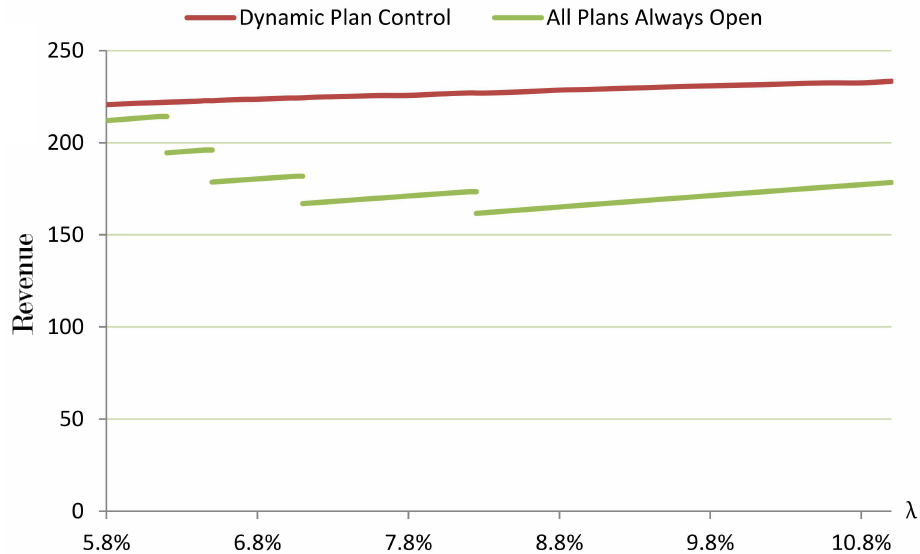
Figure 7. Relationship between revenue and potential customers’ willingness to join the